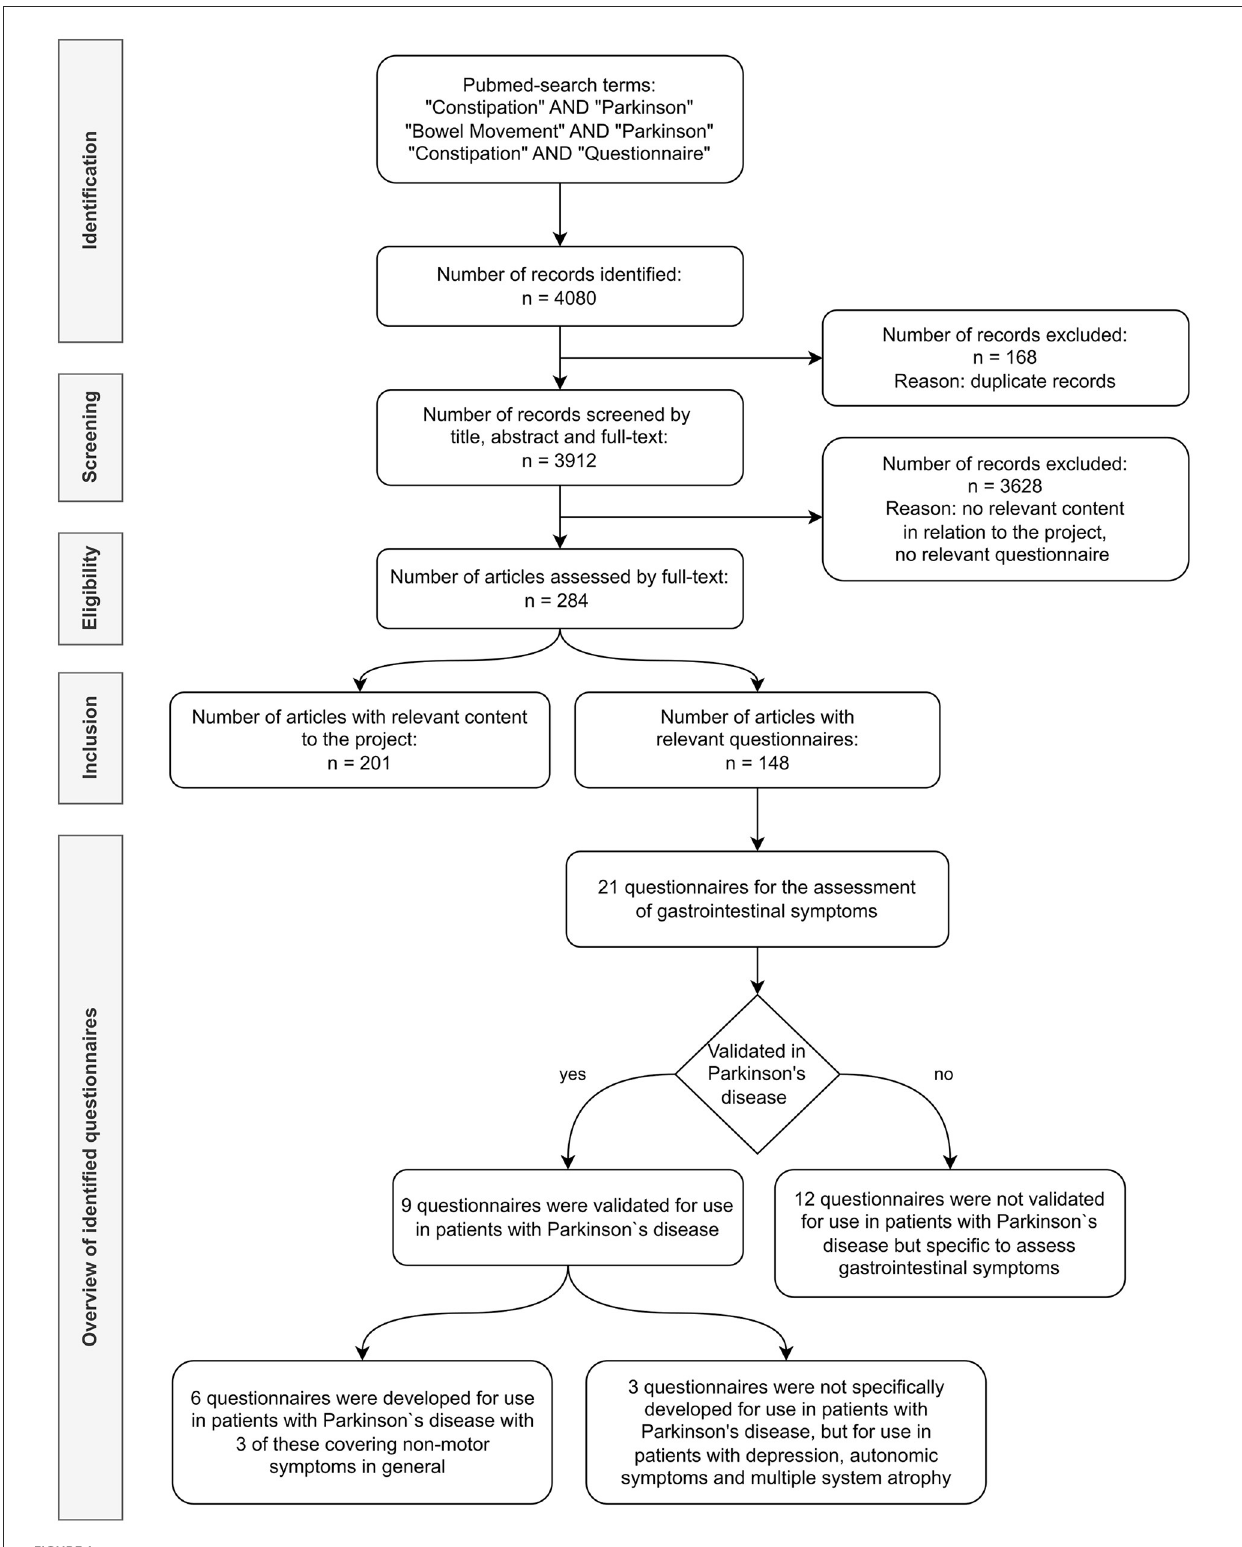
FIGURE1 Flowchart summarizing the literature search.